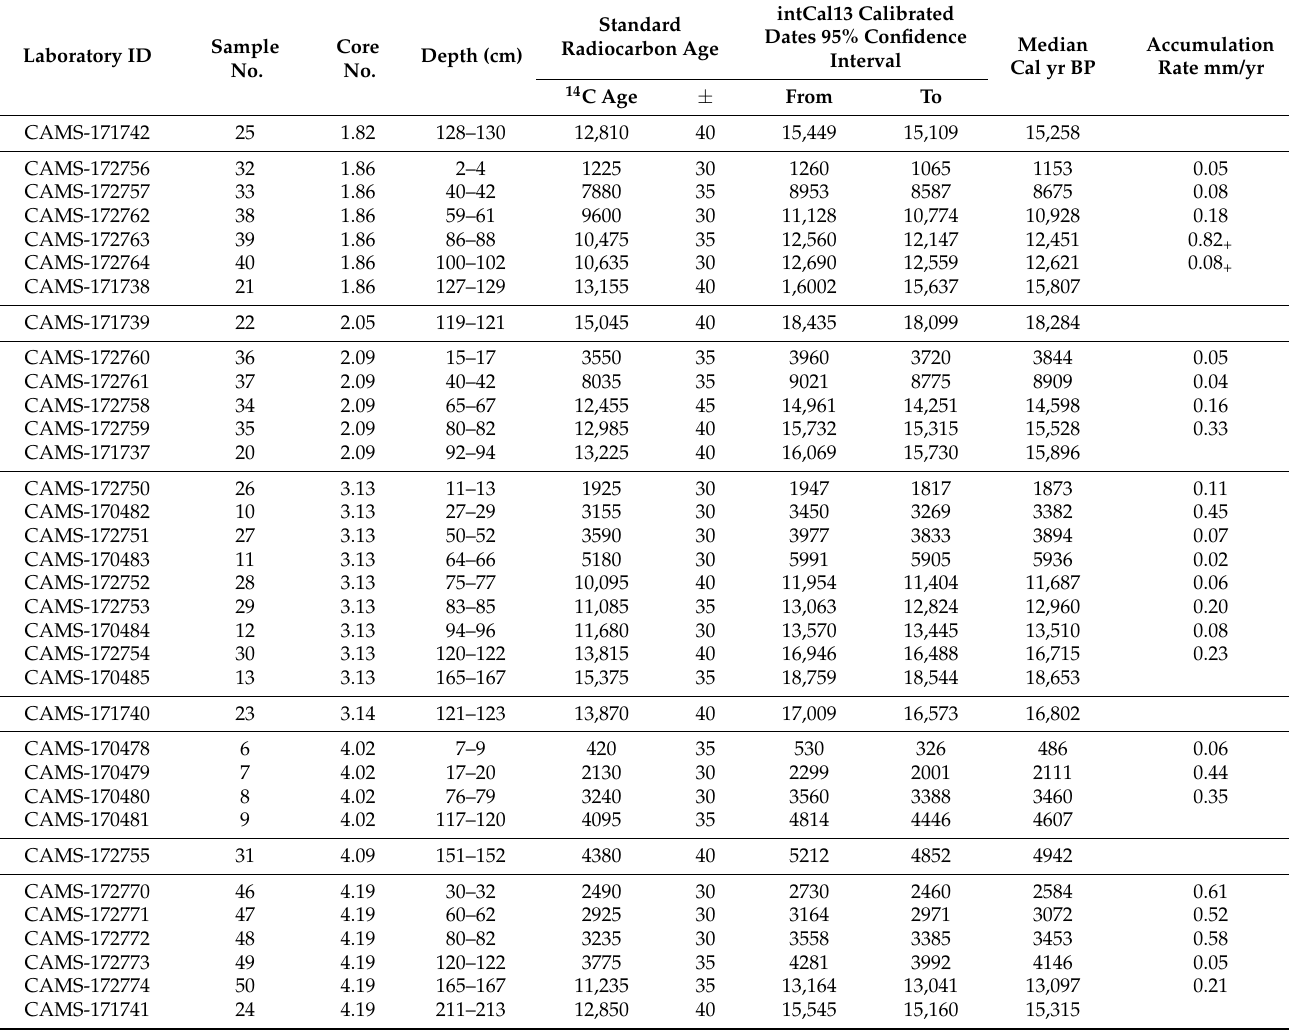
Table 1. CVNWR radiocarbon dates and accumulation rates. Dated material consisted entirely of bulk peat samples. Accumulation rates were calculated as the thickness of accumulated peat divided by the corresponding interval between calibrated median radiocarbon ages. Samples 41 and 42 were reanalyzed due to a stratigraphic inversion, likely caused by procedural error. Dates on samples 41* and 42* were in expected stratigraphic order, so these age determinations were used in analysis and interpretation. The + symbol denotes radiocarbon dates with overlapping 95% confidence intervals; mid-points were used to calculate peat accumulation rates which were used for data